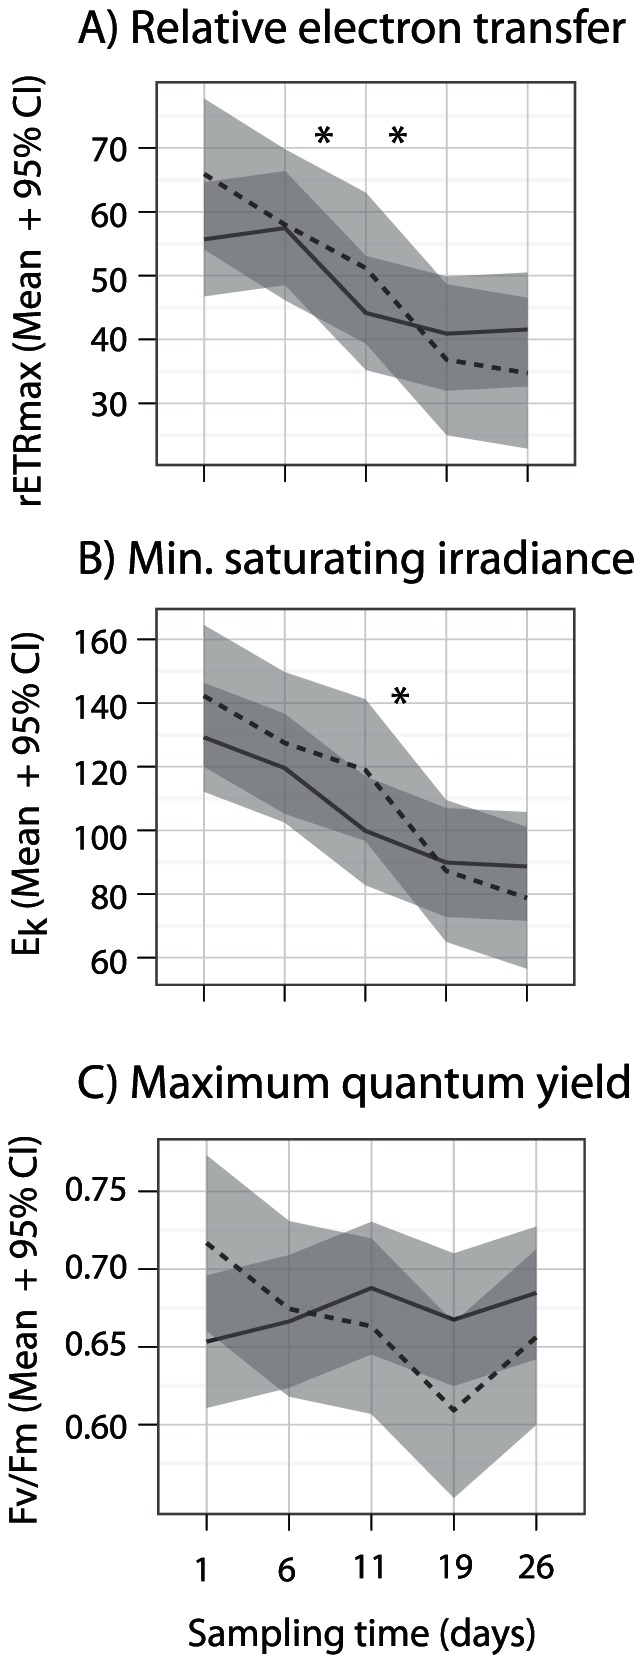
Temporal changes in photo-physiology of Symbiodinium C2 in corals translocated to a common laboratory environment.Panels represent A) mean relative electron transfer rate, B) mean minimum saturating irradiance and C) mean maximum quantum yield among replicate colonies (solid line = Davies Reef, dashed line = Orpheus Island). Grey-shaded areas represent the 95% confidence intervals of the means. Model-derived significant differences between consecutive sampling times are indicated above the plots (FDR adj. p<0.024).